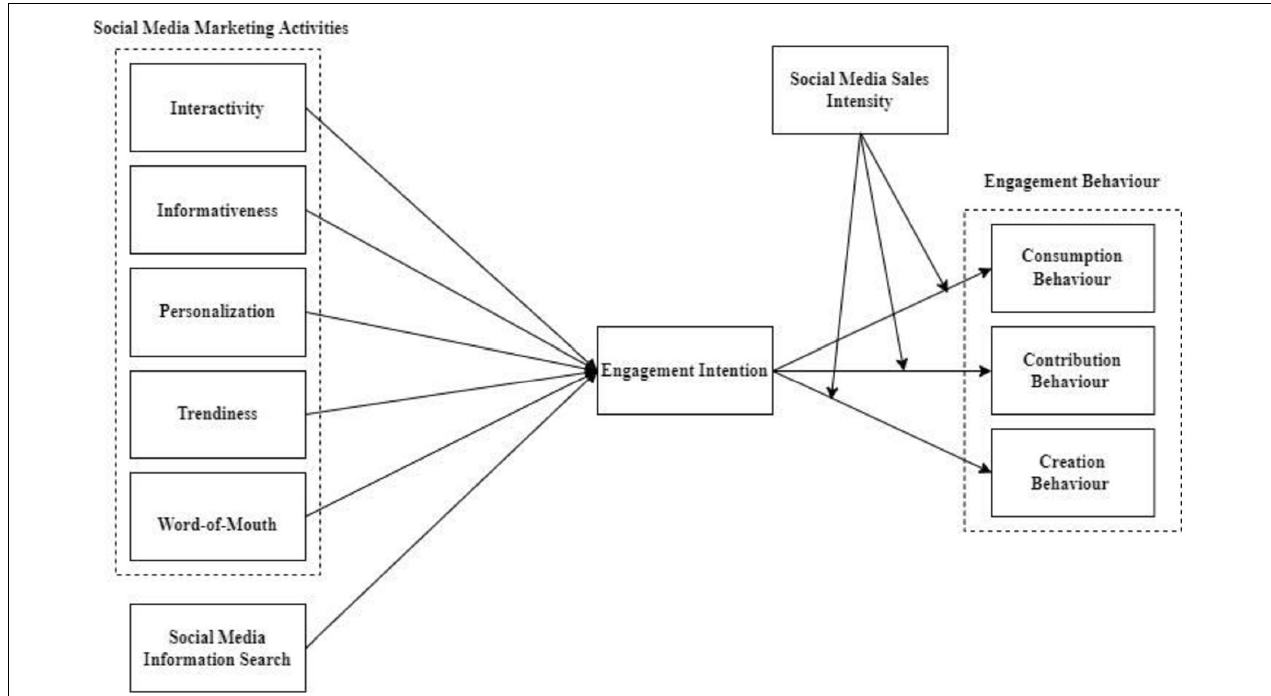
FIGURE 1 | Conceptual model of the